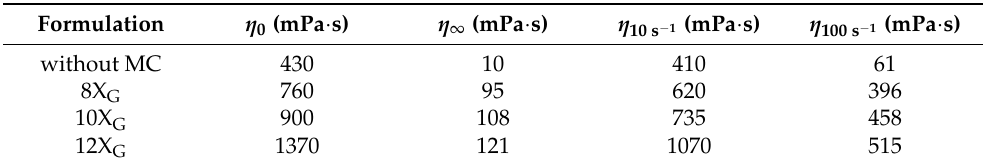
Table 1. Characteristic viscosity values for 50 vol.% Ti slurries formulated without MC and with 8, 10 and 12 g/L of